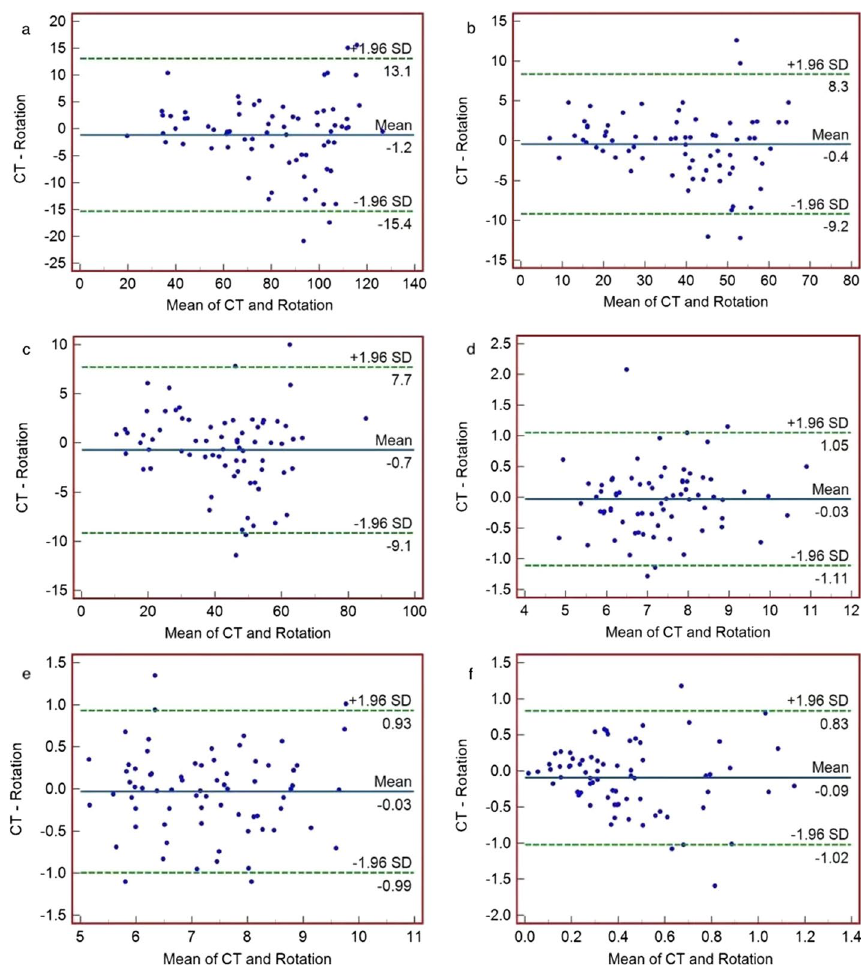
Fig. 3 Bland–Altman plots of values were determined by CT and rotation methods in 72 patients. Note: In the figure, the three solid lines from top to bottom are the upper limit of agreement (LOA) of the difference (Xd 1.96Sd), the mean of the difference (Xd), and the lower limit of the difference (LOA) (Xd-1.96Sd). Xd: + mean of the difference; Sd: standard deviation of the difference. a total renal GFR values; b left renal GFR; c right renal GFR; d left renal depth; e right renal depth; f difference in depth between the two